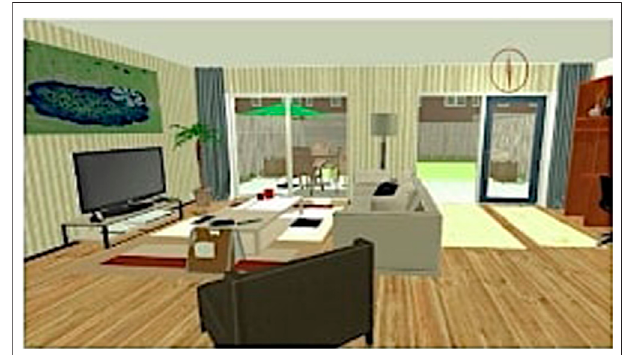
FIGURE 9 | In Lee et al. (2019), participants spent more time looking at “ see-through ” surfaces such as windows.